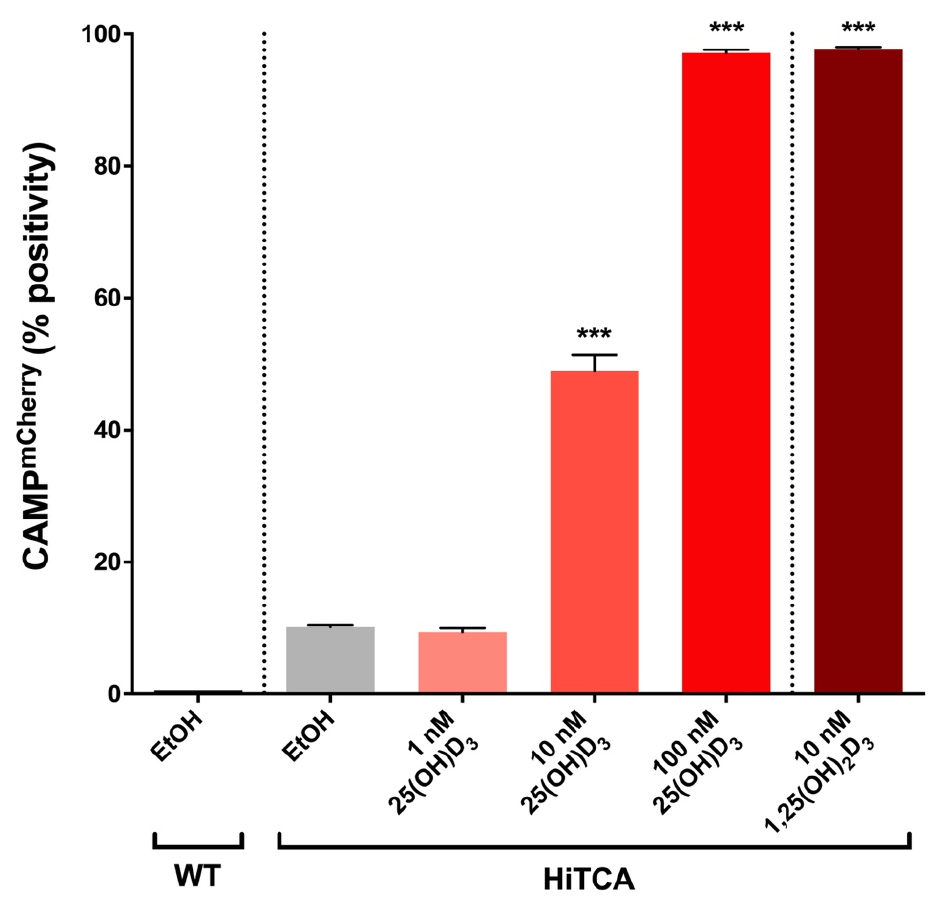
Figure 4. 25(OH)D 3 and 1,25(OH) 2 D 3 induce CAMP mCherry response in HiTCA cells. HiTCA cells were incubated in RPMI, and either EtOH (equal volume as vitamin D metabolite solvent) or vitamin D metabolites (1 nM 25(OH)D 3 , 10 nM 25(OH)D 3 , 100 nM 25(OH)D 3 , 10 nM 1,25(OH) 2 D 3 ) at 37 ◦ C for 24 h prior to flow cytometry analysis. EtOH-treated WT cells were gated to be 1% CAMP mCherry positive. Therefore, all non-WT columns represent the percentage of 10,000 live-gated single-cells that express CAMP mCherry above the WT control levels. Each column represents n = 3 biological replicates ± SD. Asterisks represent significant differences (*** p < 0.001) between vitamin D metabolite-treated HiTCA cells and their EtOH-treated